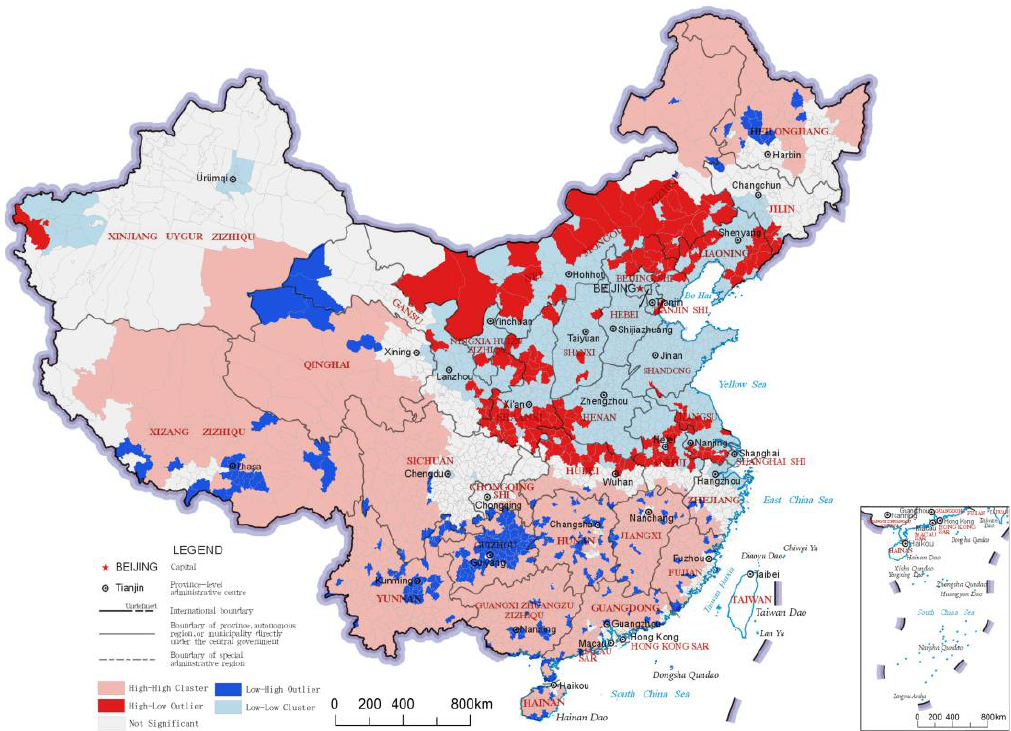
Figure 6. LISA cluster map of regulating service indices of the county-level regions in China.